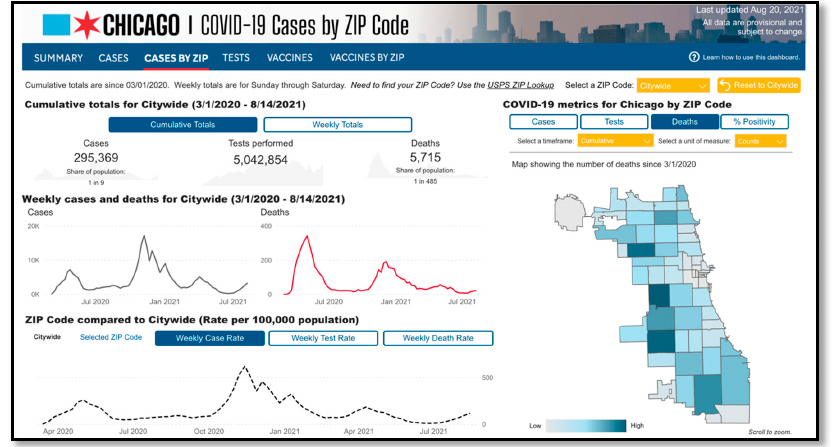
Figure 4. COVID Cases and Deaths in Greater Lawndale (zip codes 60623, 60624, 60608, 60612,